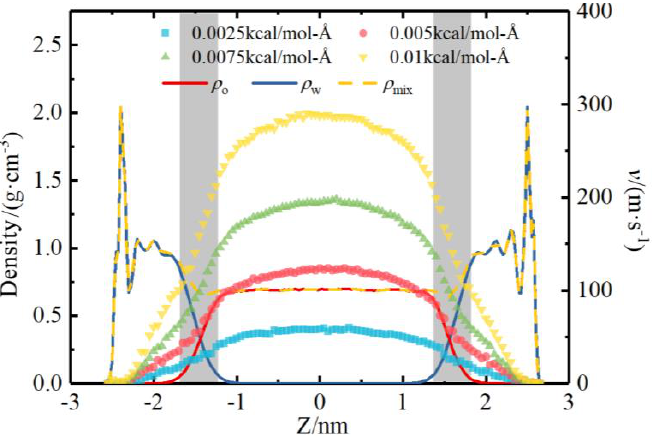
Figure 6. Fluid velocity distribution in quartz nanopores under different driven force.